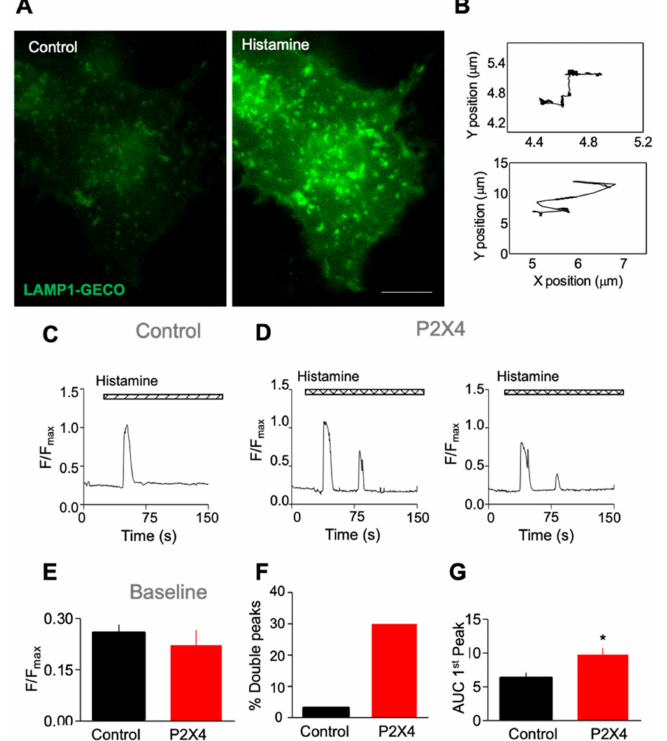
Figure 4. Expression of P2X4 alters histamine-evoked cytosolic Ca 2+ signals measured at individual lysosomes. ( A ) Representative widefield images of HeLa cells co-expressing LAMP1-GECO with rP2X4 before and after stimulation with 50 µ M histamine in Ca 2+ free HBS. Scale bar = 10 µ m. ( B ) Lysosomes were tracked during the experiment to elucidate [Ca 2+ ] c around single lysosomes, and examples of the trajectories of two different lysosomes that were tracked during a single experiment are shown. ( C , D ) Typical histamine-evoked responses recorded from single tracked lysosomes are shown for cells expressing LAMP1-GECO alone or co-expressing LAMP1-GECO with rP2X4. ( E ) There was no significant difference in the baseline fluorescence. ( F ) Percentage of tracks showing a double peak following stimulation with histamine (50 µ M) was greater in cells co-expressing rP2X4 with LAMP1-GECO, as was the area under the curve for the first peak ( G ). The total number of tracks was 57 (LAMP1-GECO alone) and 63 (LAMP1-GECO with rP2X4) collected over 3–6 independent experiments; unpaired Student’s t -test, * p <